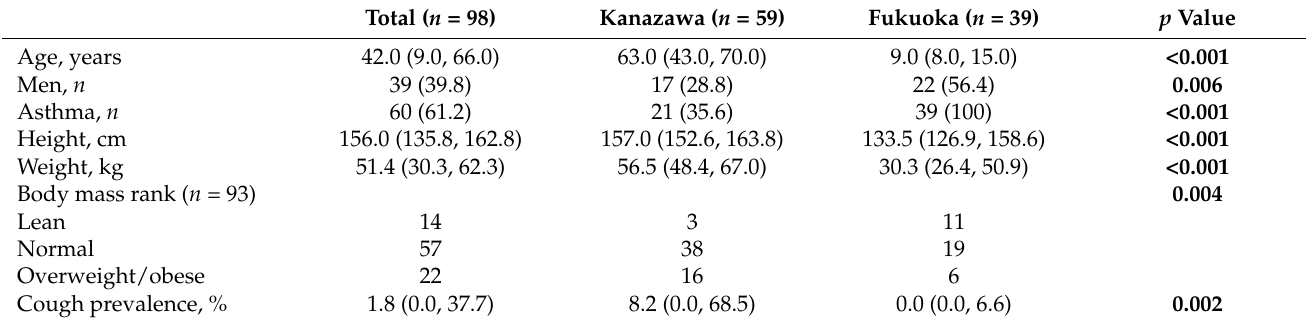
Table 1. Baseline characteristics of study participants in Kanazawa and Fukuoka.